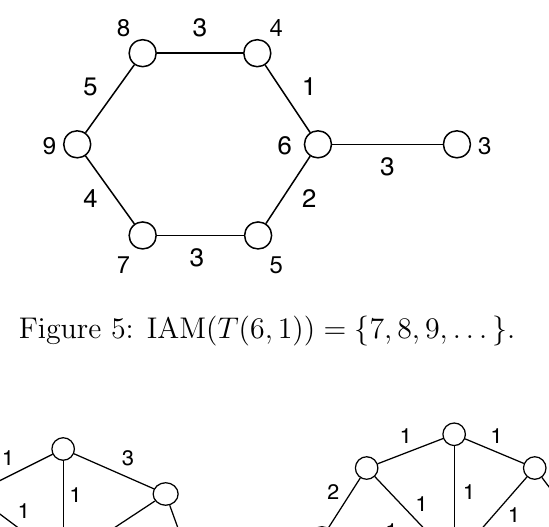
) = { 8 , 9 , 10 , . . . } and IAM( W 7